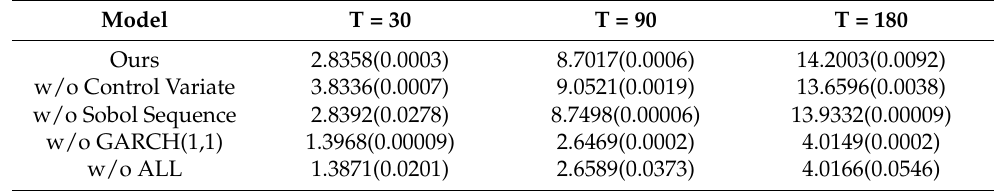
Table 4. Ablation study on the control variate and QMC method based on Sobol